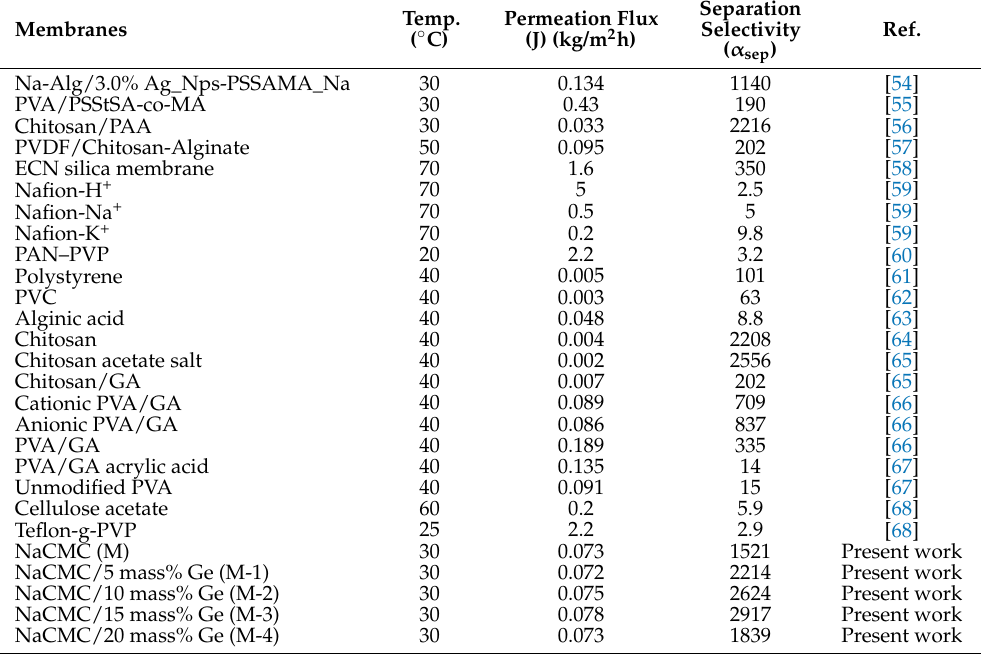
Pervaporation performance of different membranes for dehydration of ethanol at azeotropic point a